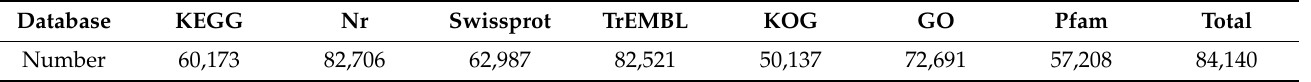
Table 1. Annotation statistics of the unigenes in the seven